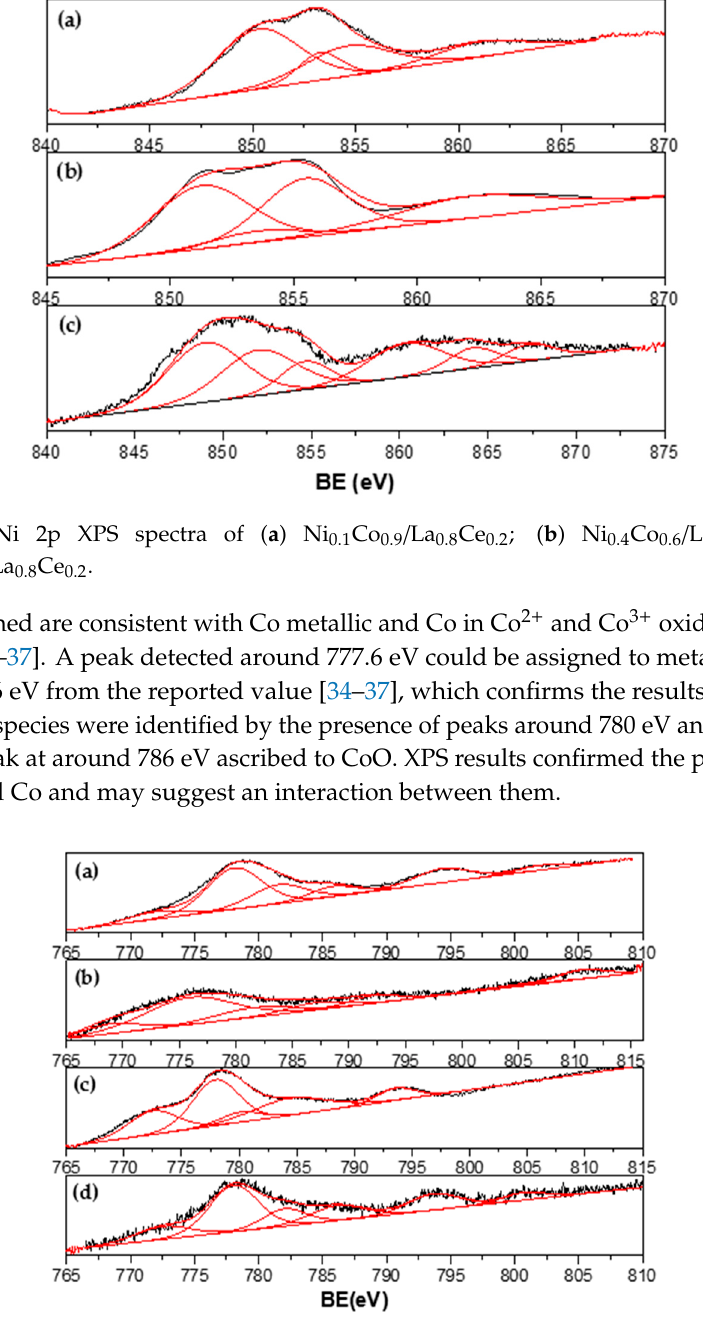
Figure 6. TEM micrographs of Ni 1-x Co x /La 0.8 Ce 0.2 catalysts: ( a ) Ni 0.7 Co 0.3 /La 0.8 Ce 0.2 ; ( b ) Co/La 0.8 Ce 0.2 ; ( c ) Ni 0.1 Co 0.9 /La 0.8 Ce 0.2 ; and ( d ) Ni 0.4 Co 0.6 /La 0.8 Ce 0.2.